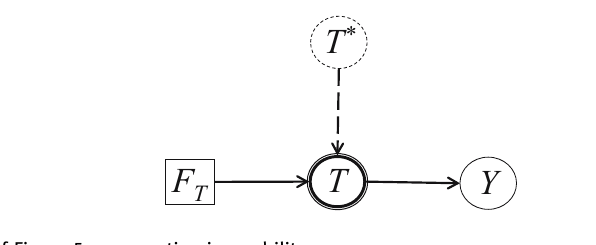
Figure 6: Modi fi cation of Figure 5 representing